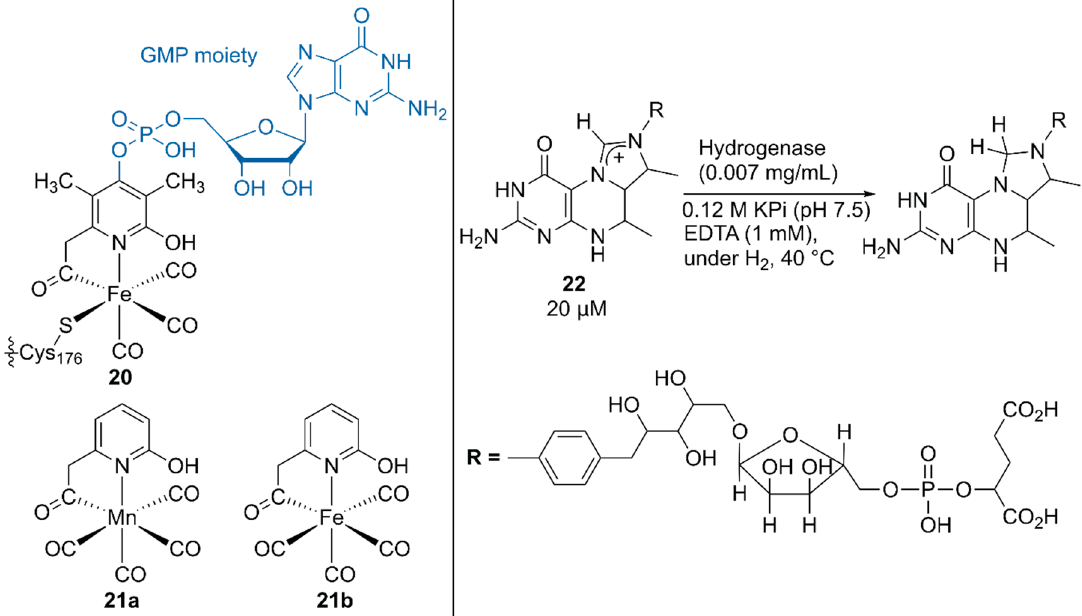
Figure 4. Structures of the native, synthetic Mn, and synthetic Fe cofactors of the hydrogenase. Adapted from [42].